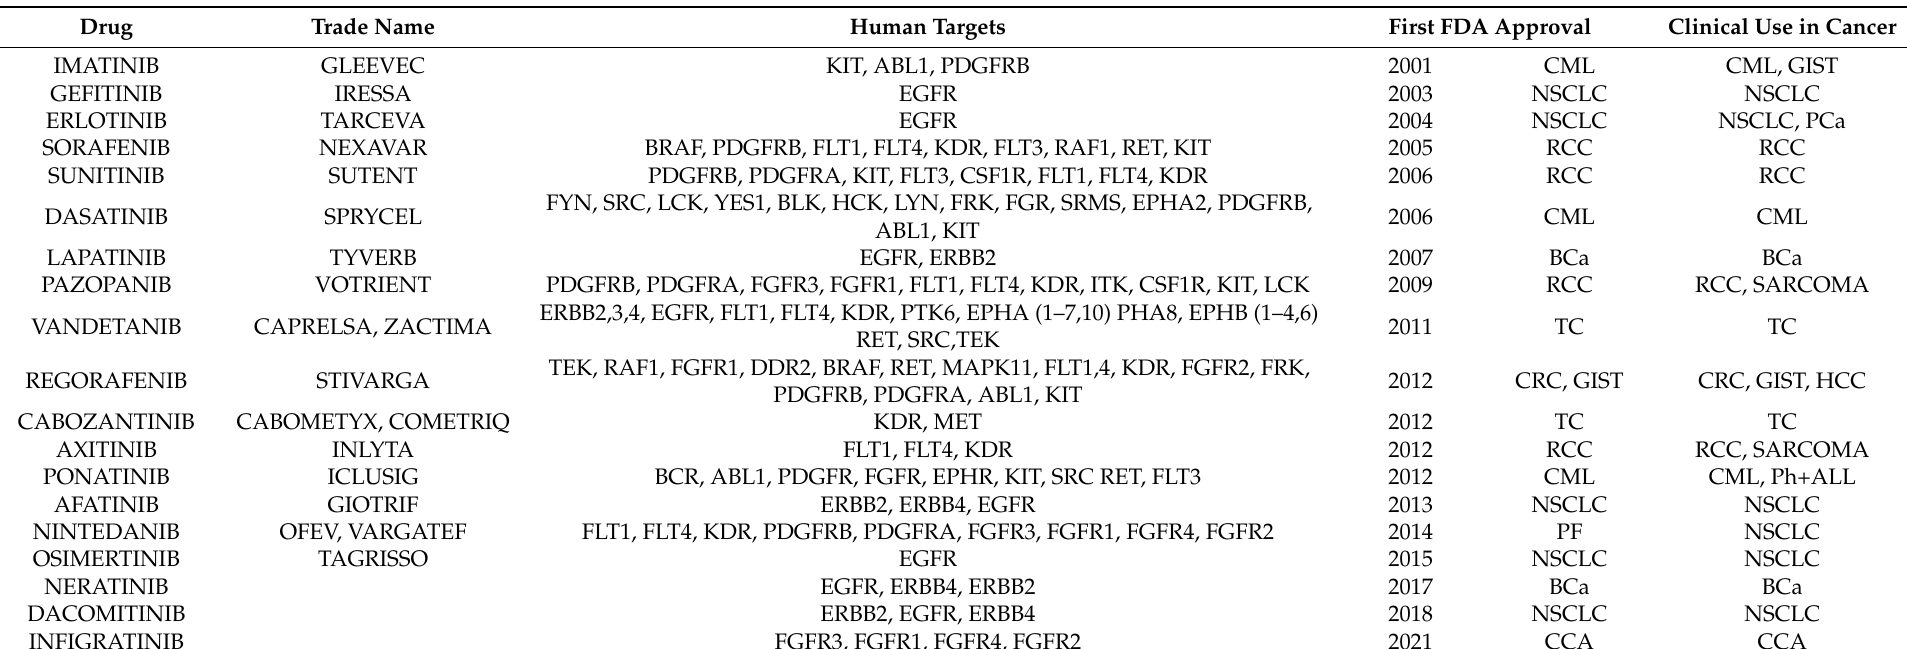
Table 1. Receptor Tyrosine Kinase inhibitors targeting drivers of GBM trialed in glioblastoma